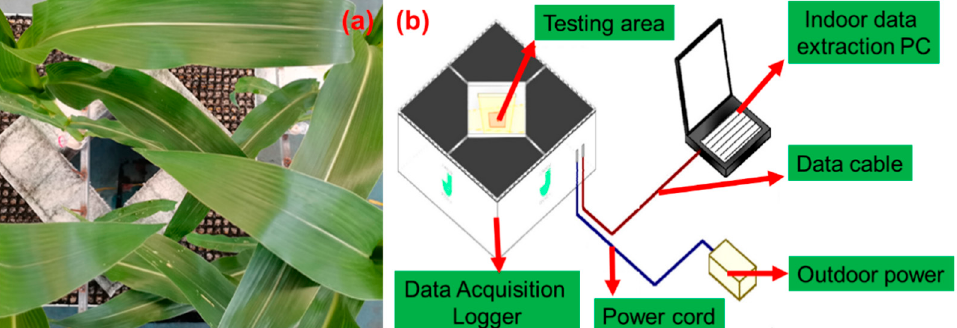
Figure 4. Droplet information acquisition equipment. ( a ) shows the actual arrangement of the maize plant with 2DVD during the experiment; ( b ) shows the arrangement of the droplet information collection